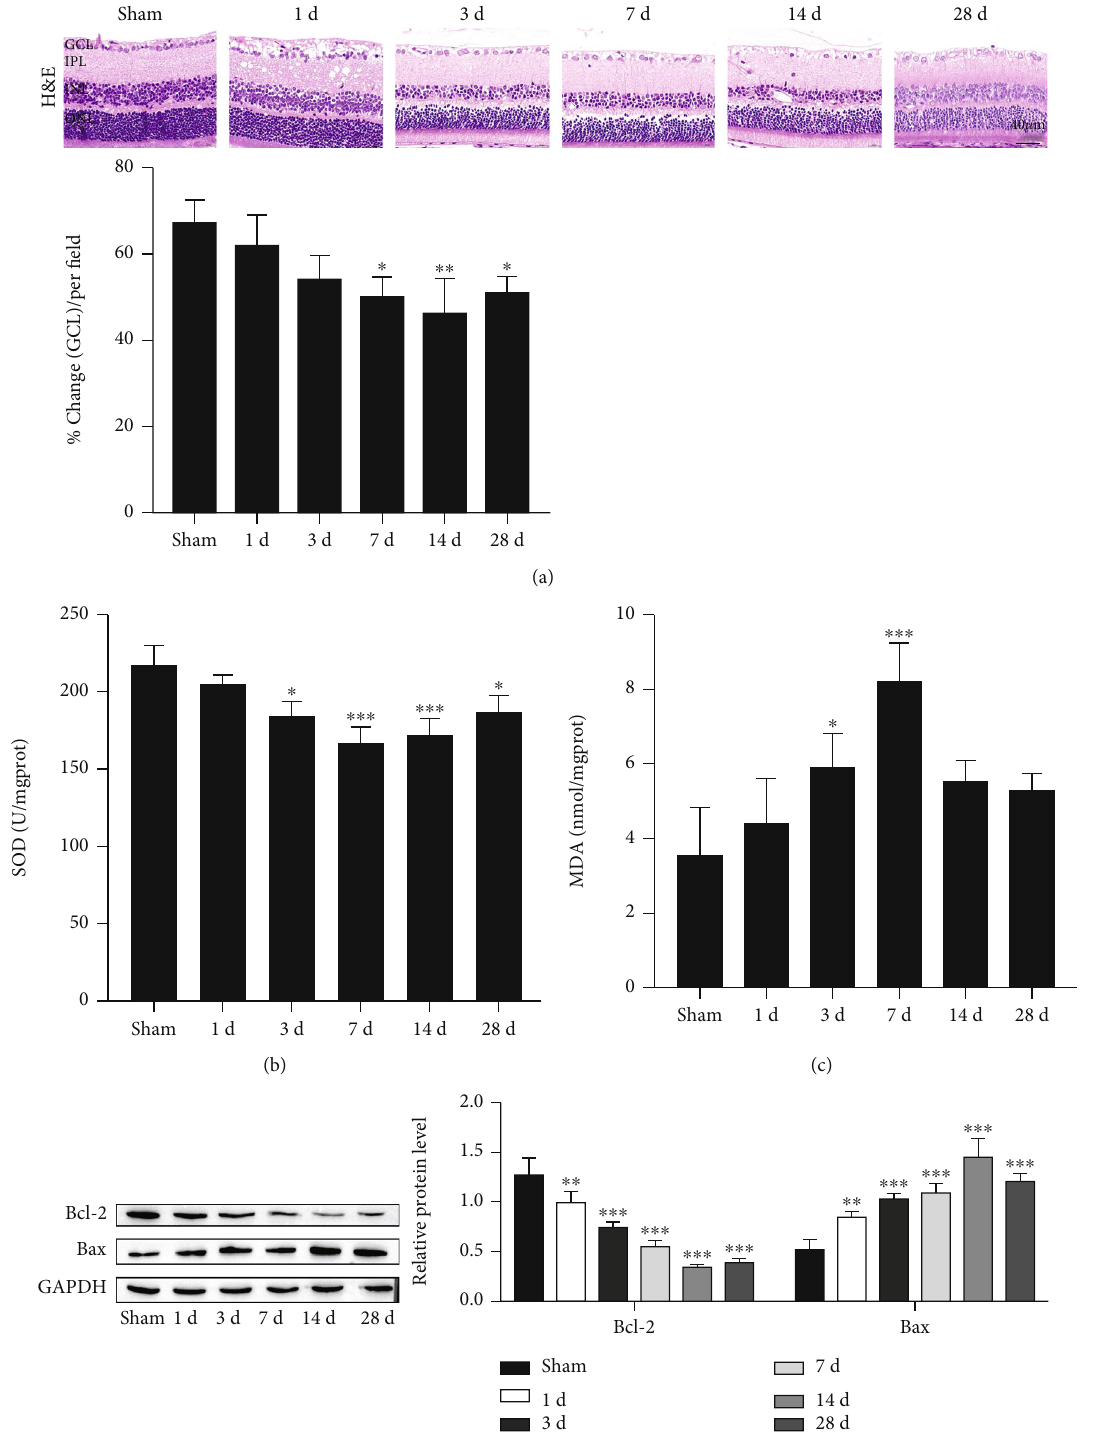
Figure 1: Trauma increases retinal oxidative stress and RGCs death. (a) Representative images of retinal tissues stained with hematoxylin and eosin (H&E; scale bar = 40 μ m). (b) Superoxide dismutase (SOD) activity. (c) Malondialdehyde (MDA) content. (d) Western blot detection of Bcl-2 and Bax proteins. ∗ P < 0 : 05 , ∗∗ P < 0 : 01 , and ∗∗∗ P < 0 : 001 vs. the sham